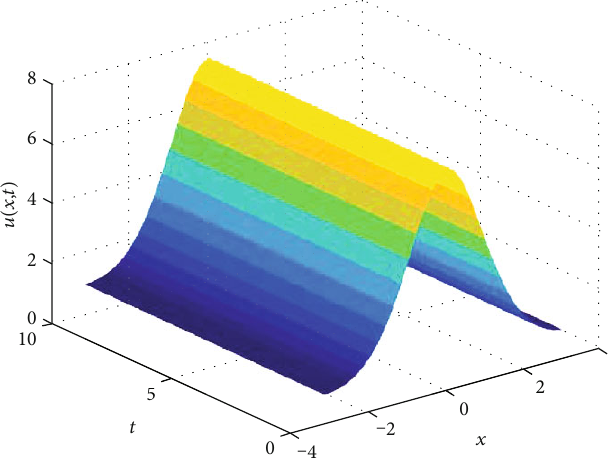
Figure 2: The exact solution on the region ½ 0, 10 (cid:2) × ½ − π , π (cid:2) for Example 1.